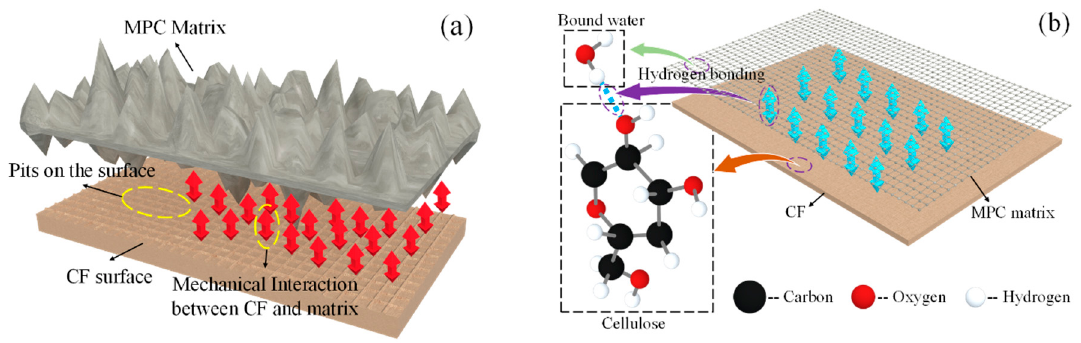
Figure 20. Bonding mechanism between CF and matrix: ( a ) mechanical interaction; ( b ) hydrogen bonding.